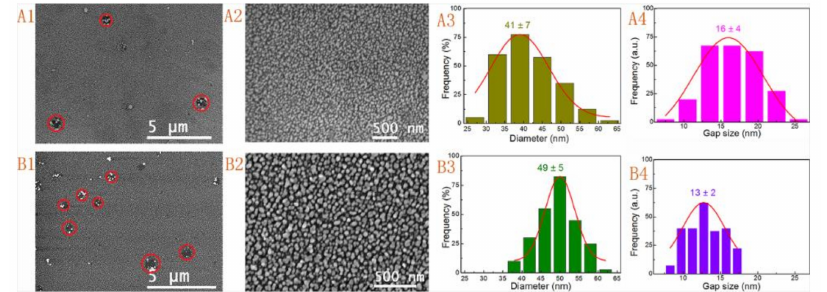
Figure 3. SEM images ( A1 , A2 , B1 , B2 ), size distributions ( A3 , B3 ), and gap size distributions ( A4 , B4 ) of Au nanoparticle films formed by utilizing seed I activation and with an immersion time of 30 min ( A1 – A4 ) and seed II activation combined with an immersion time of 12 h ( B1 – B4